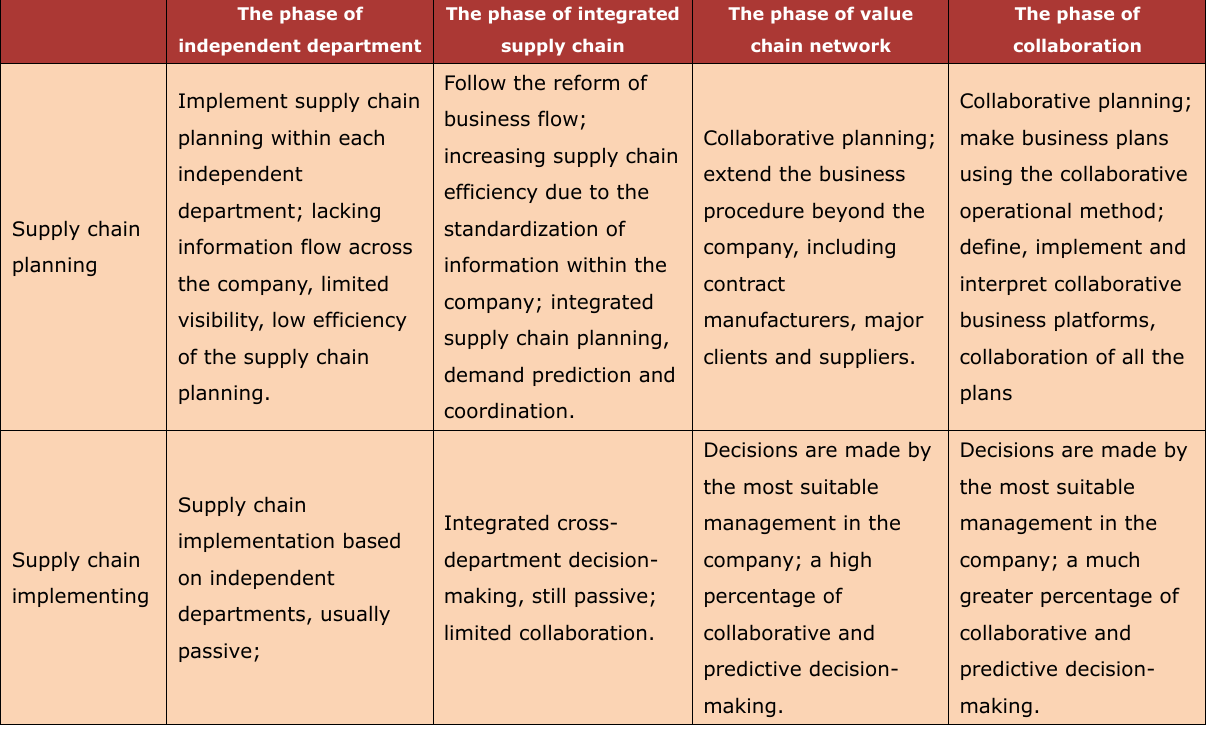
Table 1. Different phases of development of supply chain